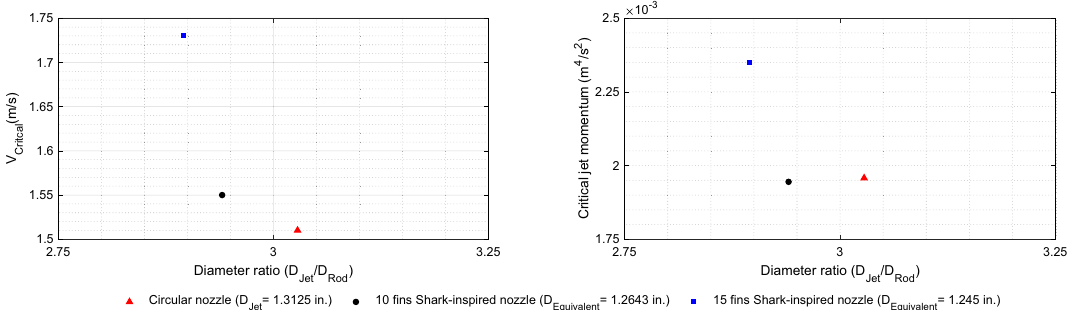
Figure 12. Comparison of critical jet velocity and momentum from the three tested